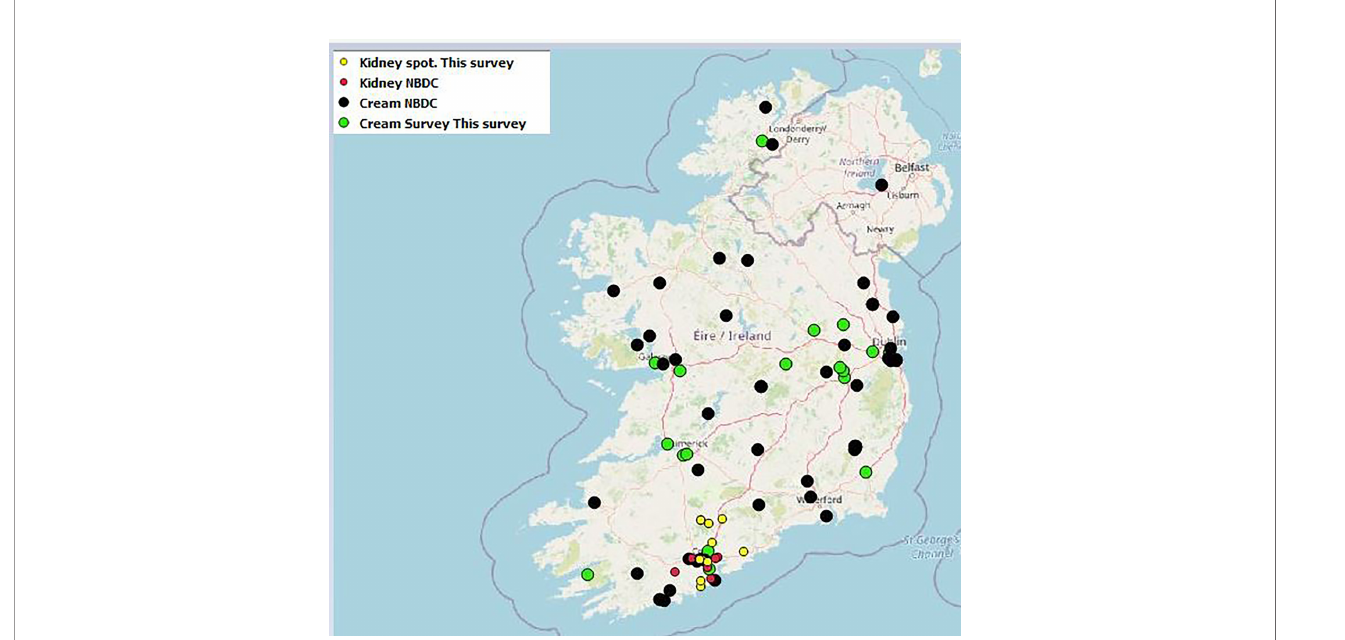
FIGURE 4 | Distribution of Chilocorus renipustulatus and Calvia quatuordecimguttata between April 2020 and June